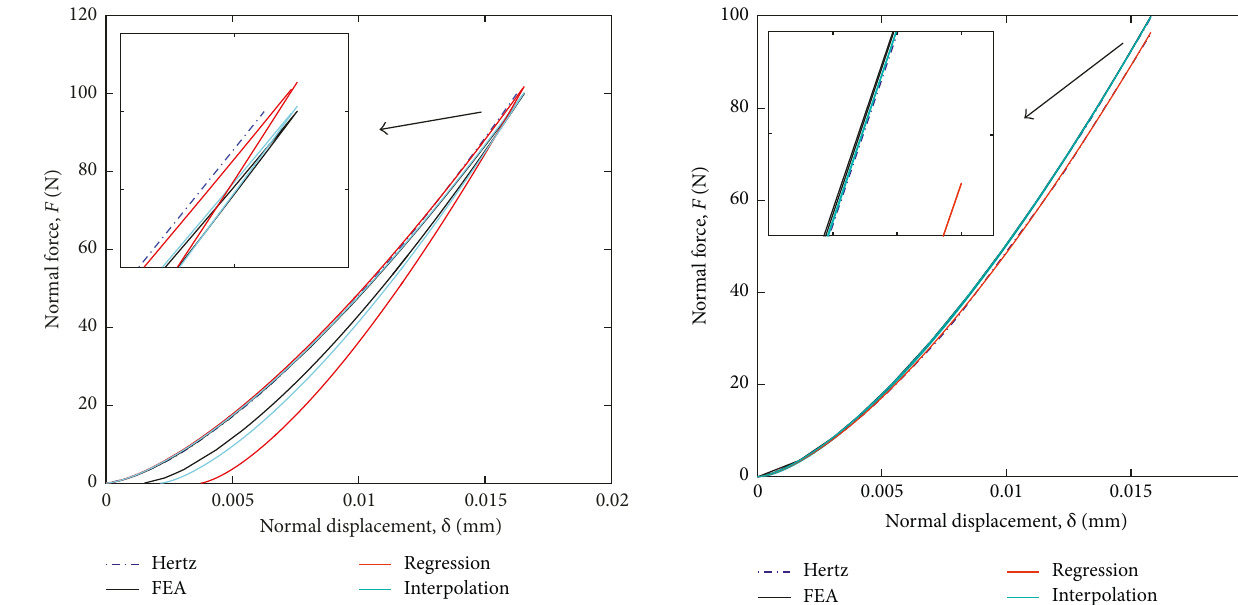
Figure 12: Normal force versus normal displacement for elastic deformation (type 2 in Table 3).